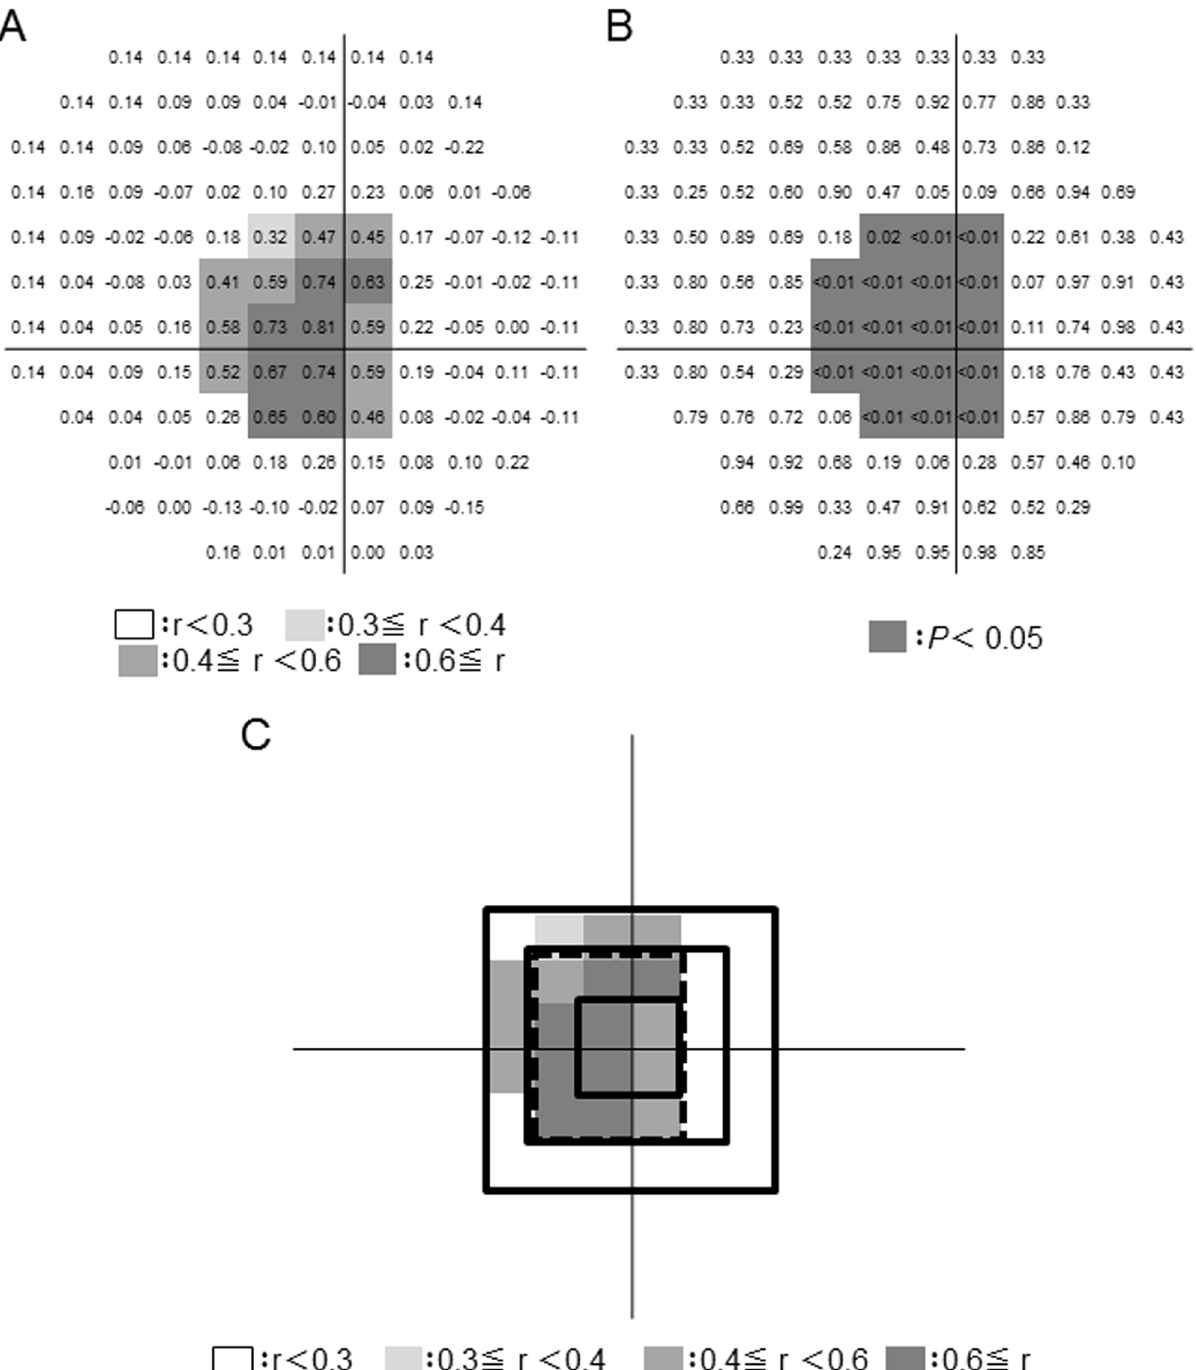
Fig 1. Distribution of the correlation between local and overall lamina cribrosa (LC) thickness in a grid superimposed on the LC. (A) The numbers in the grid cells represent Spearman ’ s rank correlation coefficient. The cells highlighted in gray had a higher correlation coefficient. (B) The numbers in the grid cells represent the P value. The cells highlighted in gray were significantly correlated ( P value < 0.05). (C) Map showing the position of 4 areas of high correlation, comprising 4, 12, 16, and 36 grid cells,